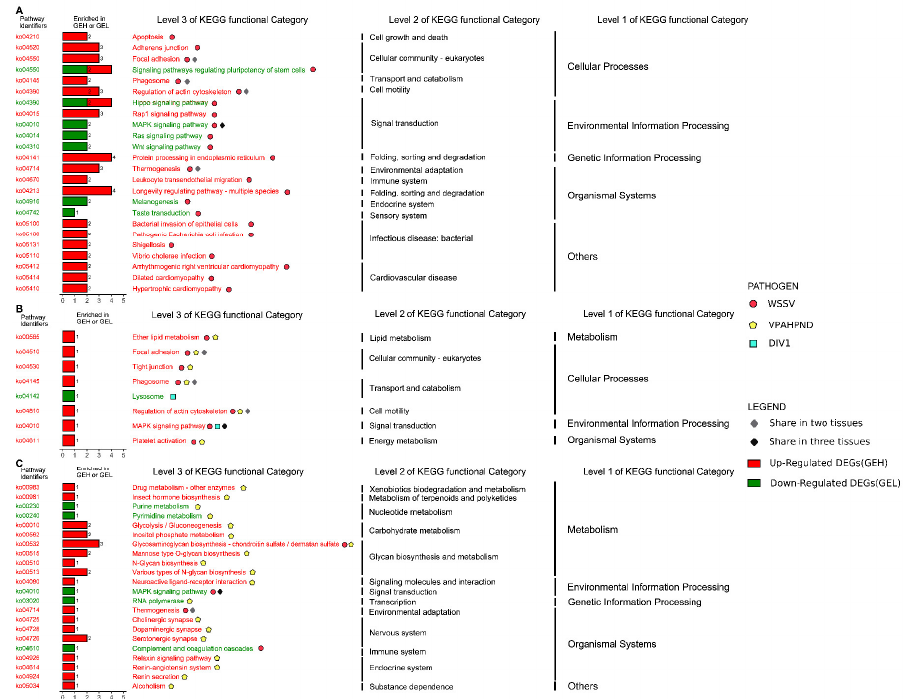
Figure 4. Results of KEGG enrichment analysis of DEGs in ( A ) gill, ( B ) hemocytes, and ( C ) hepatopancreas in WSSV, VP AHPND , or DIV1 infected P. vannamei , showing the pathway identifiers, the numbers of up-regulated DEGs (GEH, in red) and down-regulated DEGs (DEL, in green), and the corresponding KEGG level 3, 2 and 1 functional categories. The icons next to the KEGG level 3 categories indicate the types of infection, with grey diamond indicating the KEGG level 3 categories enriched in two of the tissues (gills and hemocytes or hepatopancreas), while the black diamond indicates categories enriched in all three tissues. DEGs were first assigned to a specific KEGG pathway level 2, then assigned to either one of the five KEGG level 1 category (i.e., organismal systems, metabolism, genetic information processing, environmental information processing, and cellular processes).